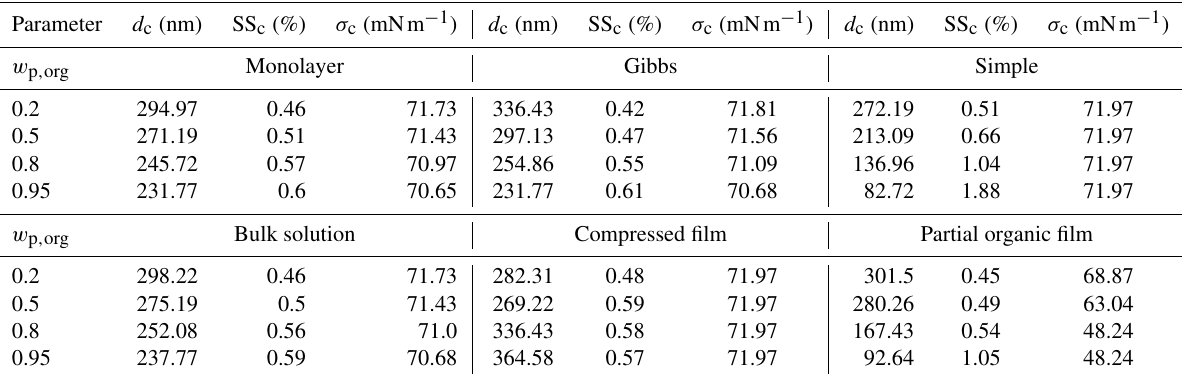
Figure 4. Malonic acid surface partitioning factors ( n S org /n T org ) predicted with the different models along the Köhler curves for dry particles with D p = 50nm at different organic mass fractions ( w p , org ). The critical points are also marked. Table 3. The critical droplet diameters ( d c ), supersaturations (SS c ) and surface tensions ( σ c ) predicted with the different models in simula- tions for mixed malonic acid–ammonium sulfate particles of D p = 50nm at